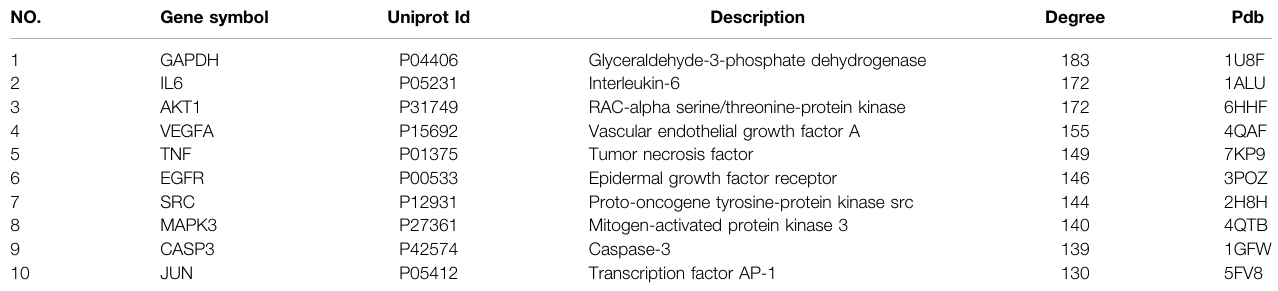
TABLE 1 | Ten key targets of Hugan tablets in treating DILI.